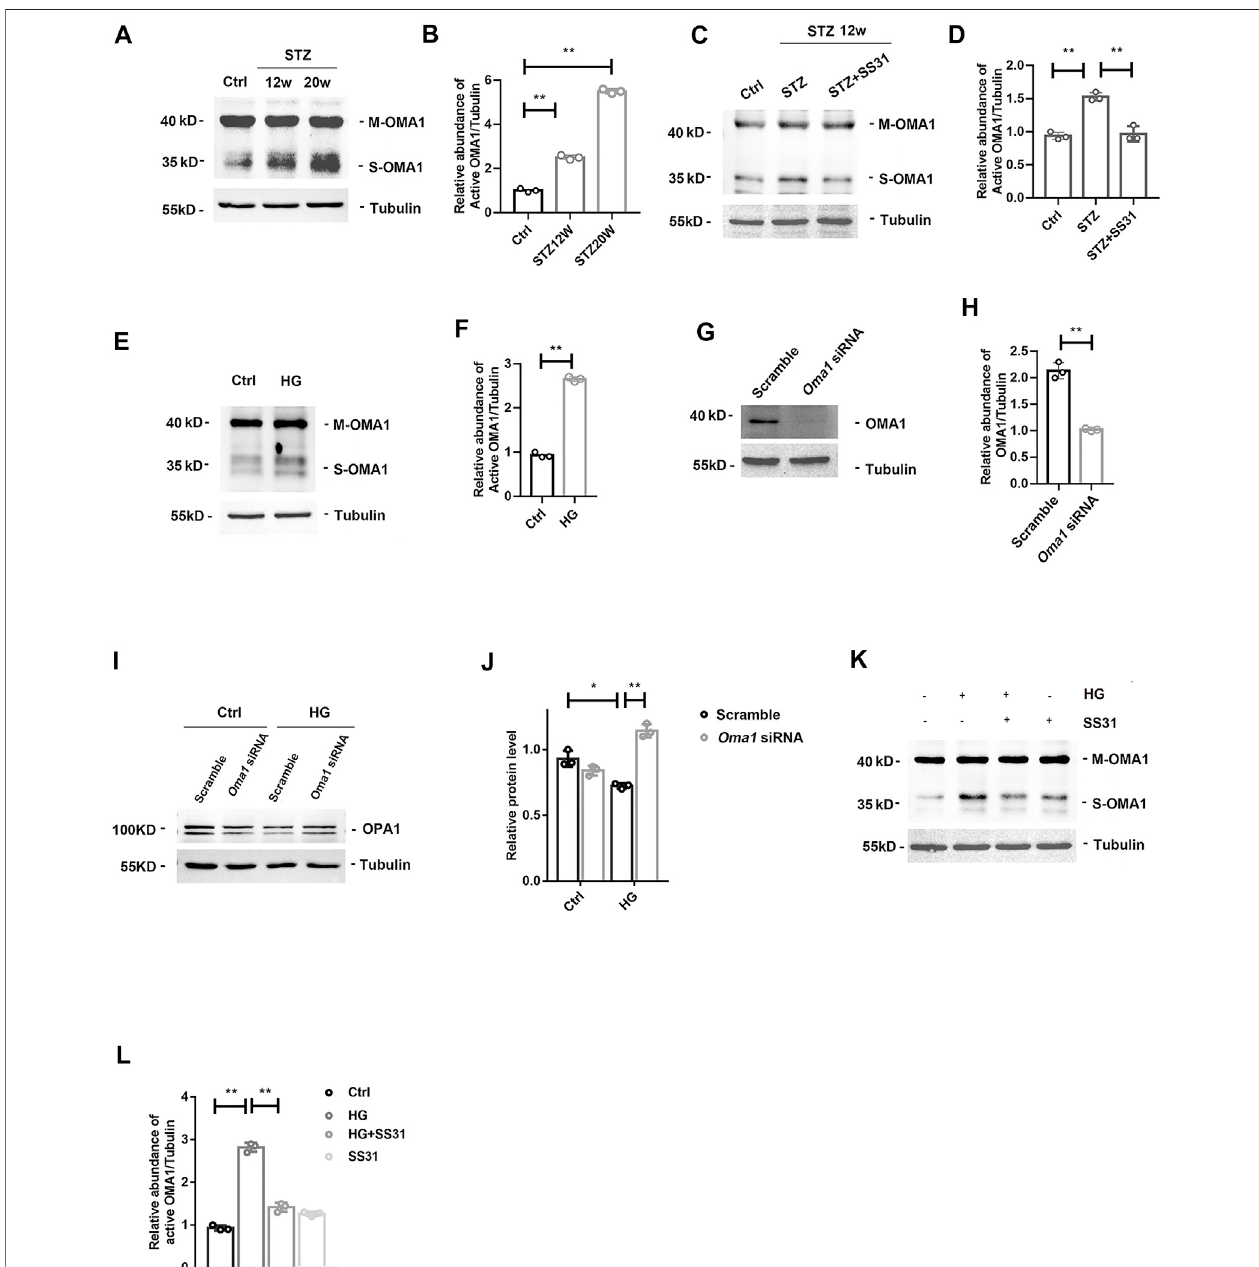
FIGURE 6 | SS31 inhibits HG-induced OMA1 activation to stabilize OPA1 expression. (A,B) Western blot analysis showing glomerular mature form of OMA1 (M-OMA1)and shortform ofOMA1(S-OMA1) expression inmice afterSTZ injection for12and20 weeks.n (cid:1) 3,** p < 0.01: p < 0.001(CtrlvsSTZ12w), p < 0.001(Ctrl vs STZ20w). (C,D) Western blot analysis showing glomerular OMA1 expression in diabetic mice with or without SS31 treatment. .n (cid:1) 3, ** p < 0.01: p < 0.001(Ctrl vs STZ), p (cid:1) 0.002(STZ vs STZ + SS31) . (E) Western blot analysis showing mature form of OMA1 (M-OMA1) and short form of OMA1 (S-OMA1) expression of podocytes treated with HG (30 mM) for 24 h. (F) Semi-quantitative densitometry analysis for relative S-OMA1 expression. n (cid:1) 3. ** p (cid:1) 0.002. (G,H) Immunoblot of OMA1 in podocytes transfected with or without Oma1 -siRNA. n (cid:1) 3, ** p (cid:1) 0.003). (I,J) Immunoblot ofOPA1 in HG-treated podocytes transfected with or without Oma1 -siRNA.n (cid:1) 3, ** p < 0.01, * p < 0.5: p (cid:1) 0.02 (Scramble + Ctrl vs Scramble + HG), p (cid:1) 0.006 (Scramble + HG vs Oma1 +HG). (K) Western blot analysis showing M-OMA1 and S-OMA1expressionofpodocytesunderHGinthepresenceorabsenceofSS31for24H. (L) Semi-quantitativedensitometryanalysisforrelativeS-OMA1expression.n (cid:1) 3. ** p < 0.01: p < 0.001(Ctrl vs HG), p (cid:1) 0.003(HG vs HG +